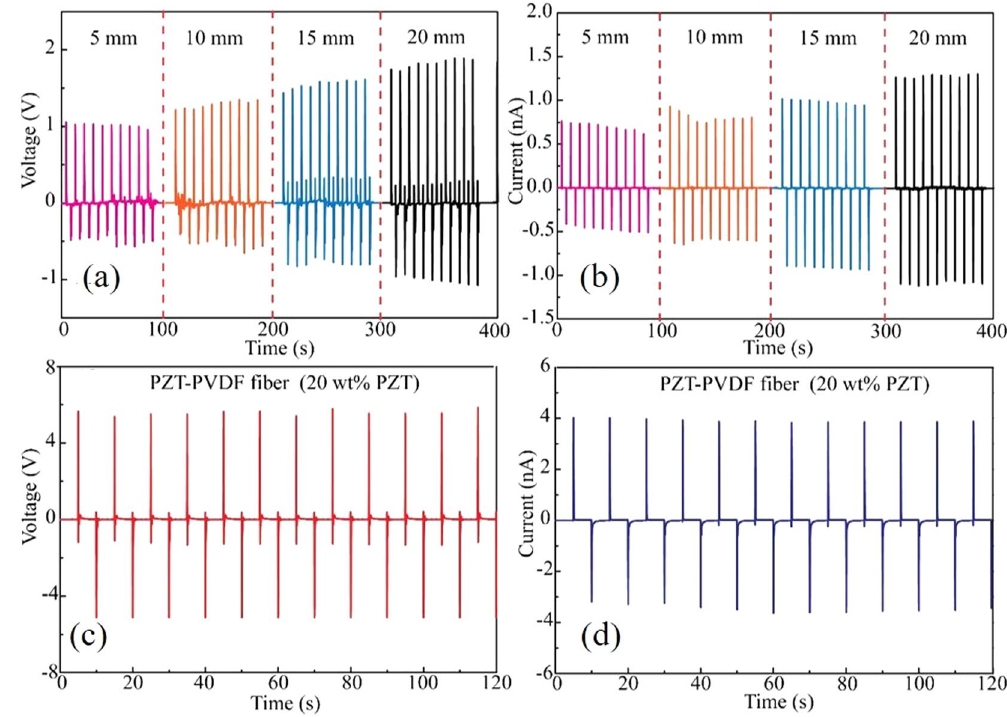
Figure 6. Performance of the piezoelectric microstructured fibers. ( a ) and ( b ) Show the generated output voltage of the fiber-based generator under bending cycle at different bending displacements (5, 10, 15, and 20 mm). ( c ) and ( d ) Show the output voltages and current sgenerated by a 10 cm-long PZT-PVDF fiber generator (20 wt.% PZT in the PZT-PVDF composite) when subjected to a 10 mm bending